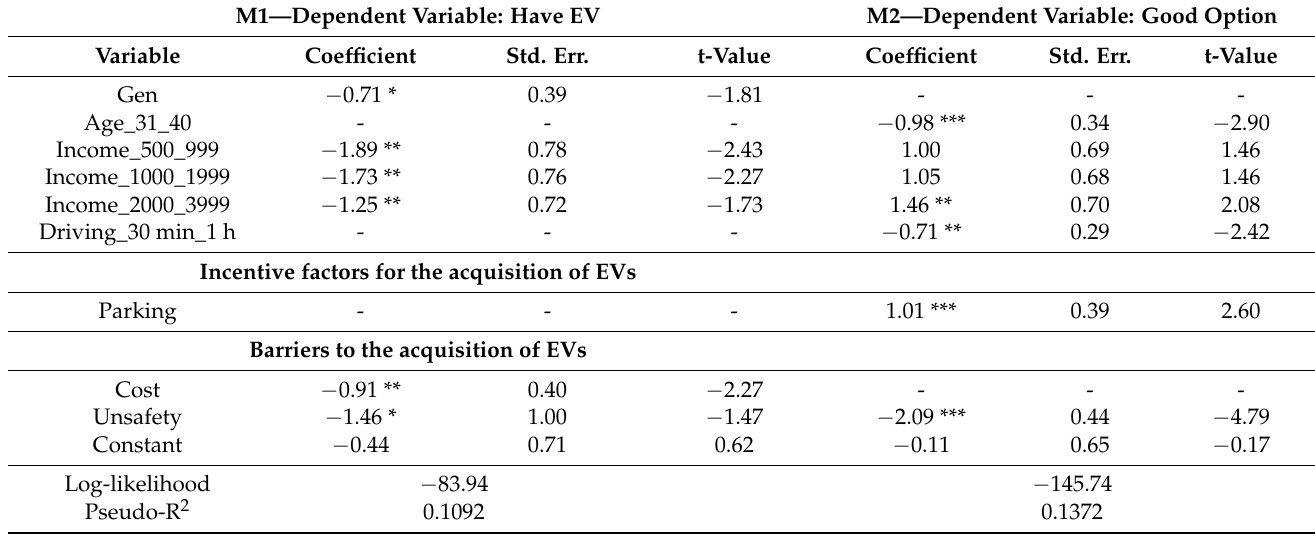
Table 7. Binary logit model results using only statistically significant independent variables for the Domestic